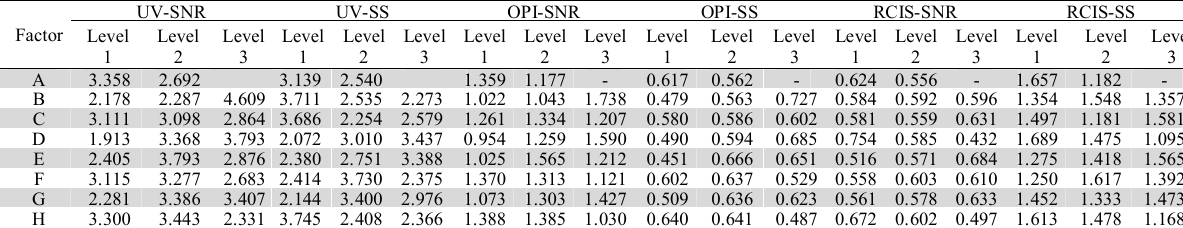
Level averages on UT-SNR, UT-SS, OPI-SNR, OPI-SS, RCIS-SNR and RCIS-SS (case study 1) Factor